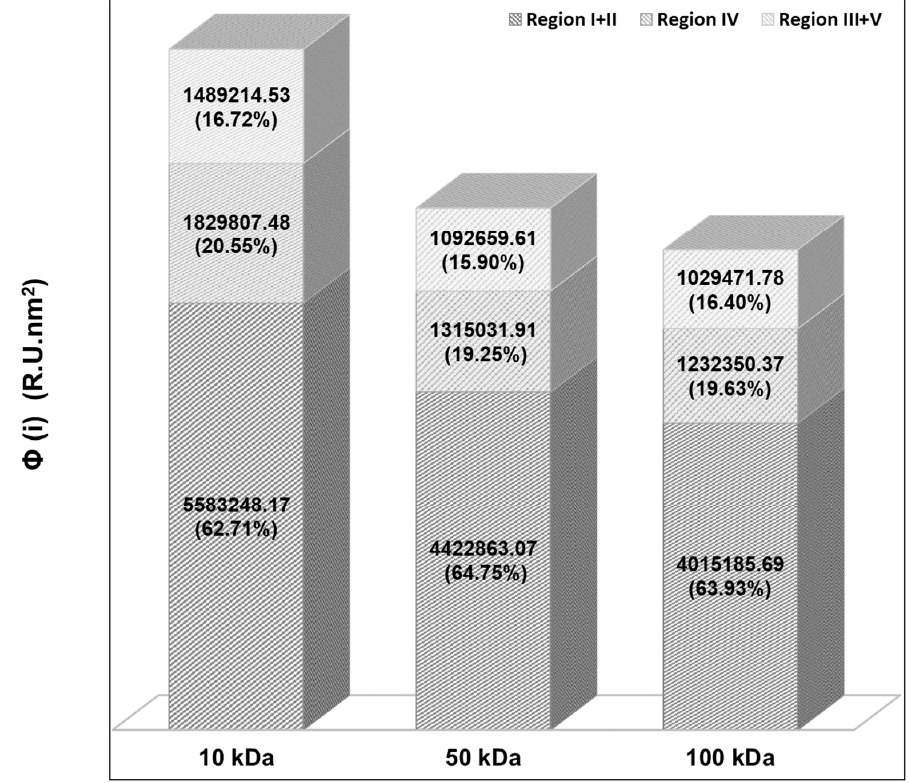
Figure 8. Volume of fluorescence distribution of foulants extracted from the fouled PES UF membranes.